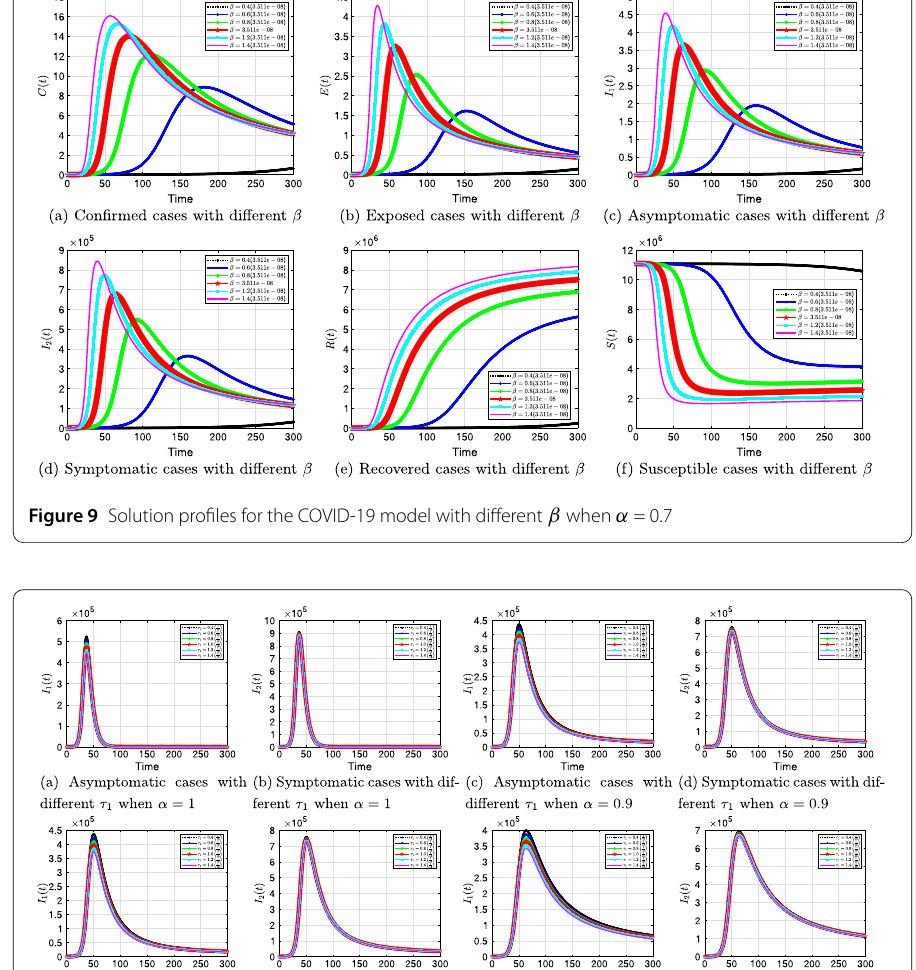
infection in the symptomatic compartment from about 7.5 × 10 5 to 5.7 × 10 5